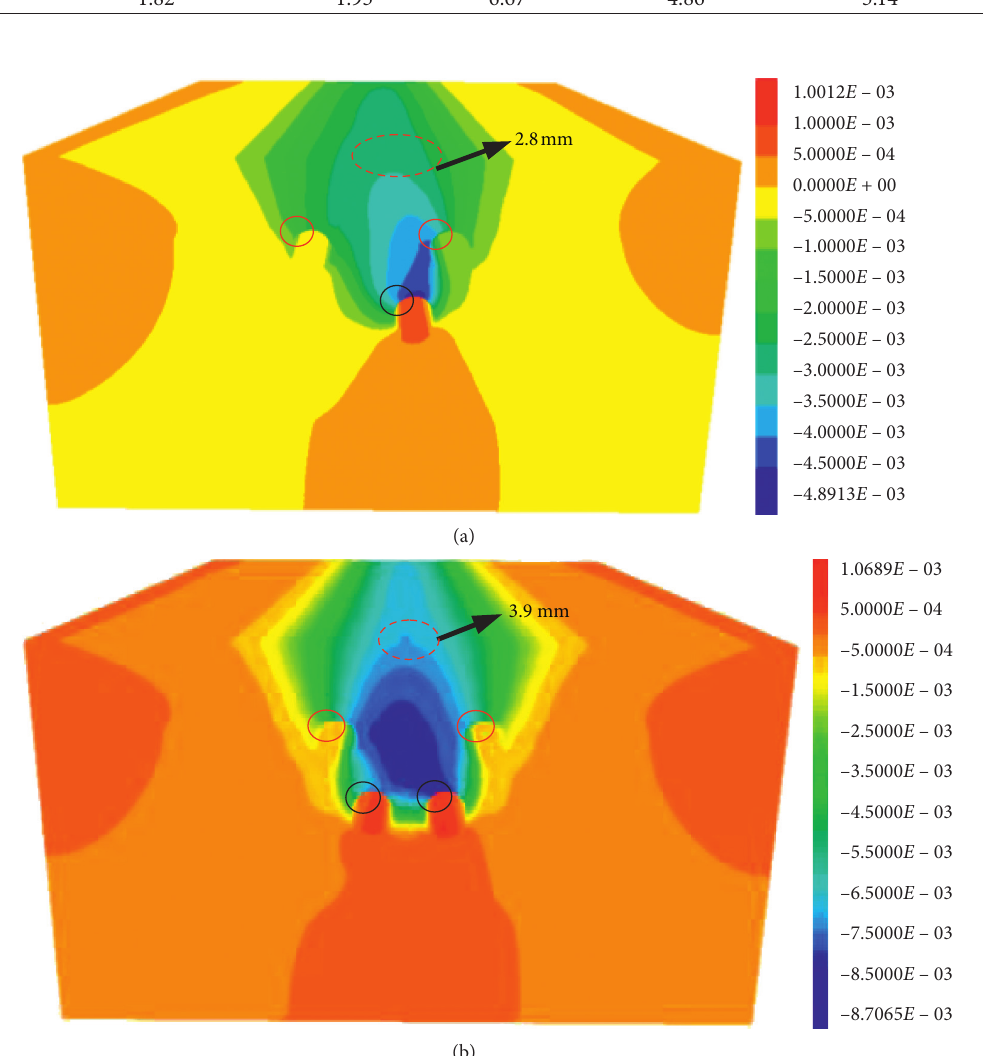
Figures 5: Simulation results of surface settlement (unit: m). (a) After the construction of right-line tunnel of line 5. (b) After the construction of double-line tunnel of line